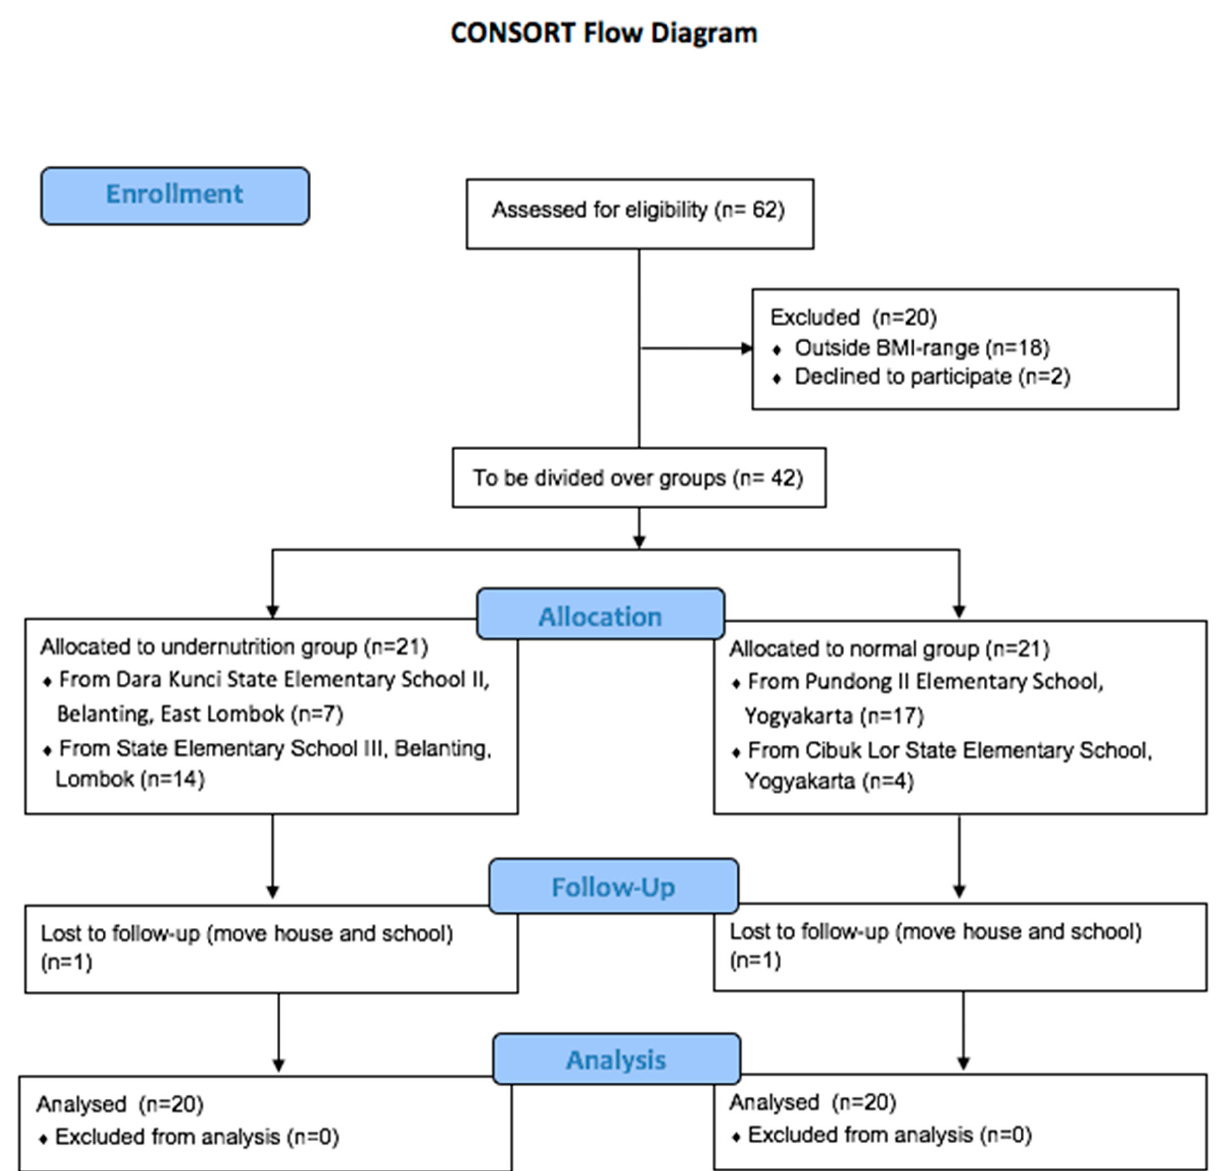
Figure 1. CONSORT flow diagram of the case–control study. Table 1. Characteristics of 40 Indonesian subjects in this study.